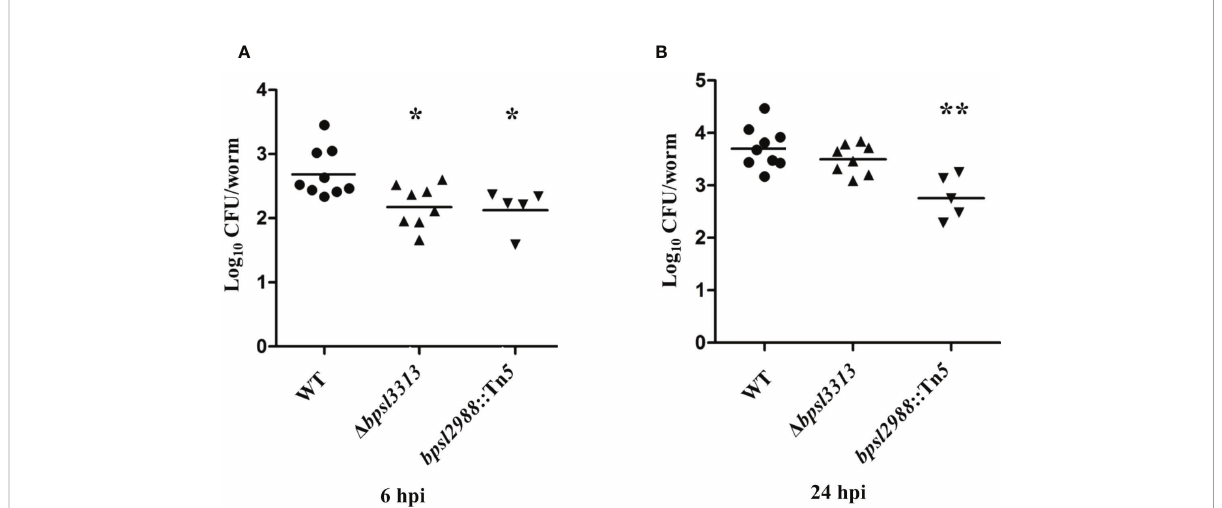
FIGURE 6 Colonization ability of B. pseudomallei wild type (WT) and mutants in C elegans intestinal lumen at (A) 6 hours and (B) 24 hours post-infection (hpi). Each marker corresponds to the average bacterial CFU (log 10 ) extracted from 10 infected worms with horizontal lines signifying the geometric mean. The asterisks represent p values of the WT counts versus the mutants ( t -test, * p <0.05, ** p